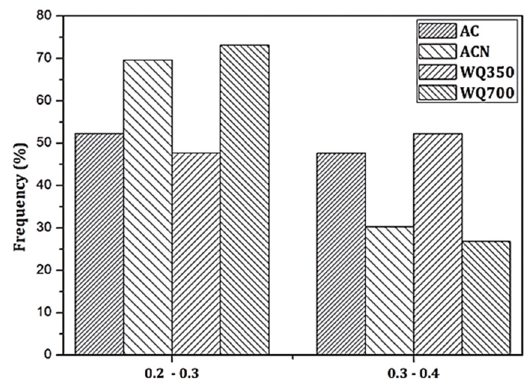
Figure 9: The variation of Taylor factor value in